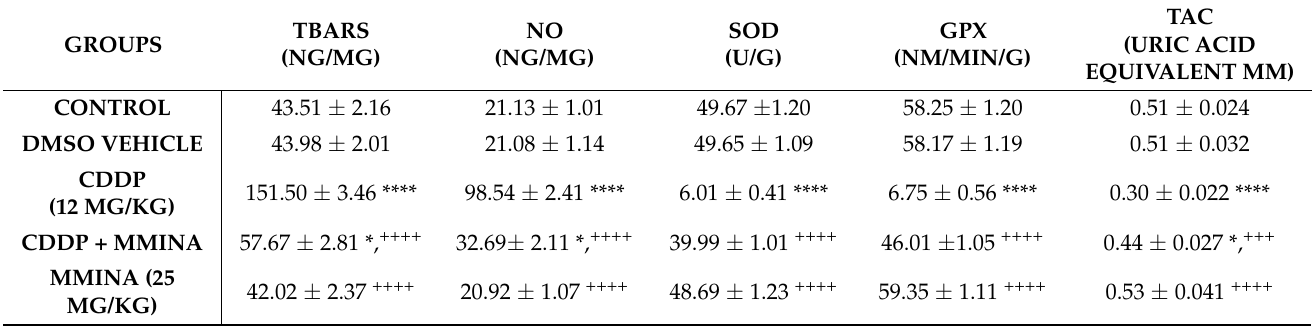
Table 2. Effect of various treatments on testicular redox status and total antioxidant